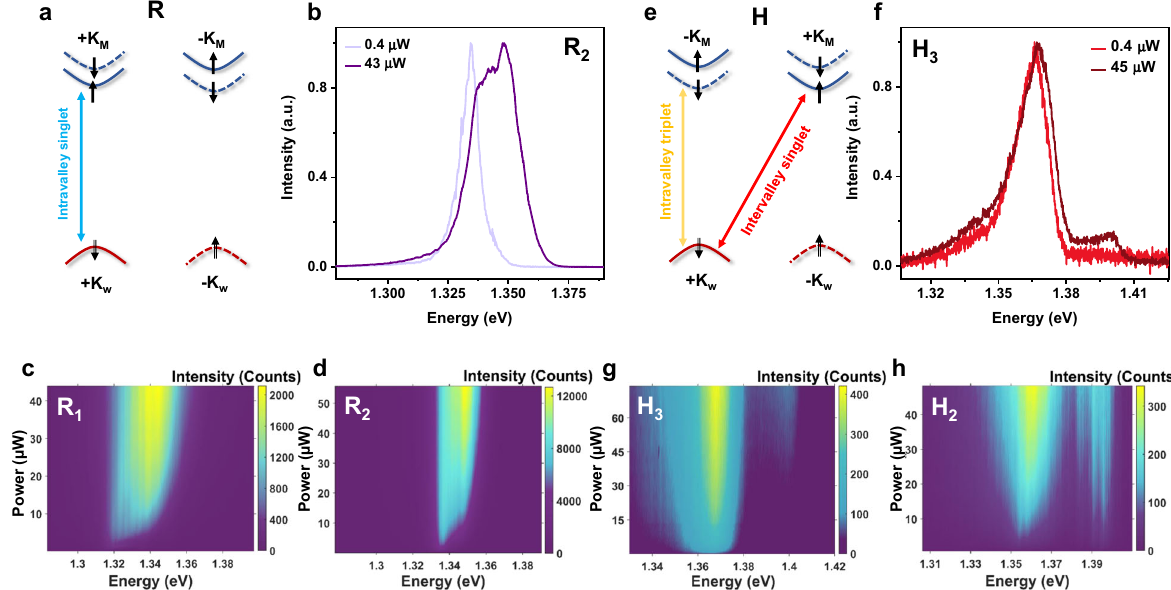
Fig. 3 Energy diagrams and power dependence of R- and H-type heterostructures. a Energy diagram of IXs in R-type heterostructures showing the ± K valley conduction band of the MoSe 2 nearly aligning with the ± K valley valence band of the WSe 2 . The solid arrow depicts the spin of the electrons, the split arrow depicts the spin of the holes, and the K subscripts label the layer. One of the optically bright intravalley singlet transitions is shown in blue between the + K valley of both MoSe 2 and WSe 2 (i.e., + K W to + K M ). b Example of normalized R- type PL spectra at low and high excitation powers. c , d Power-dependent PL spectra for two different R-type samples show the onset of a high energy shoulder with increasing power. e Energy diagram of IXs in H-type heterostructures showing the ± K valley conduction band of the MoSe 2 nearly aligning with the ∓ K valley valence band of the WSe 2 . The lowest energy direct transition is an intravalley triplet (yellow), composed of an electron and hole of the same spin in the same valley. The red arrow depicts the intervalley singlet transition. f Example of normalized H-type PL spectra at low and high excitation powers. g , h Power-dependent PL spectra for two different H-type samples. T = 1.6 K for all